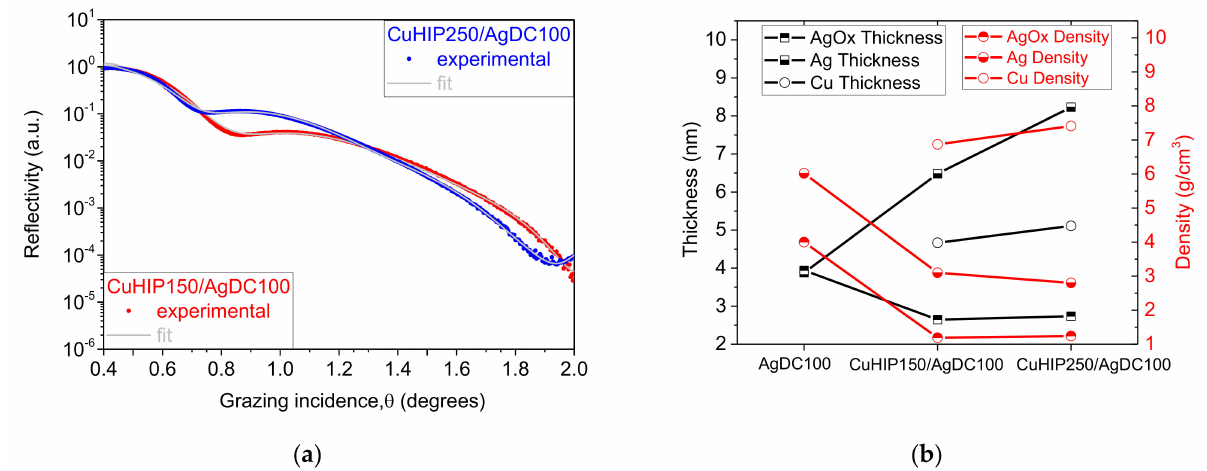
Figure 11. XRR spectra of Cu/Ag bilayers (scattering), and the fitting of the spectra (full line) ( a ); along with the resulted density and thickness variation as a function of Cu content (the error bars are within symbol limit) ( b